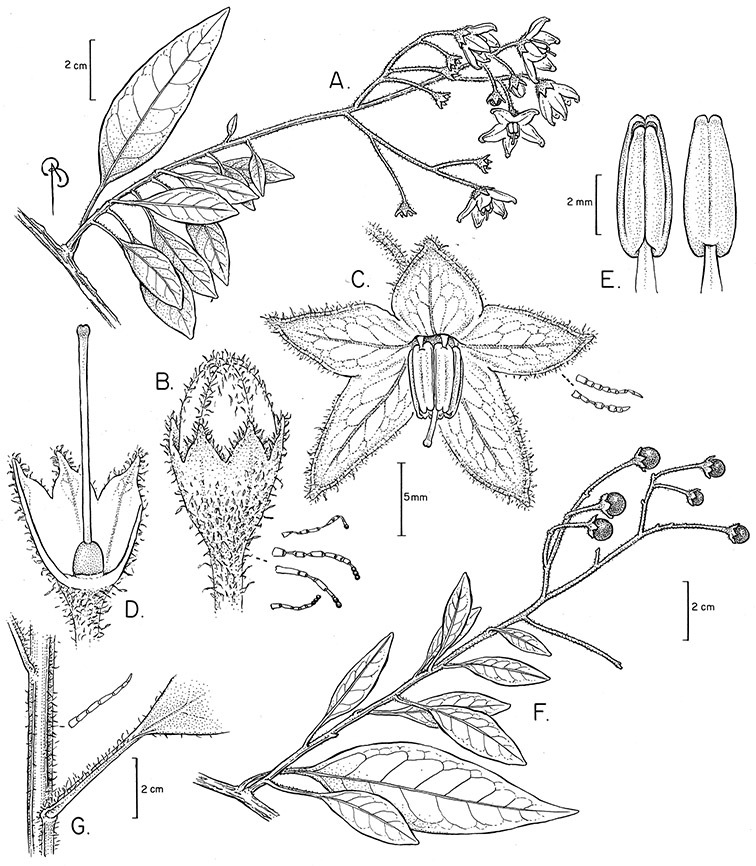
Solanum kulliwaita S.Knapp. (A–E drawn from Valenzuela 3163
F–G drawn from Galiano 6137). Illustration by Bobbi Angell.